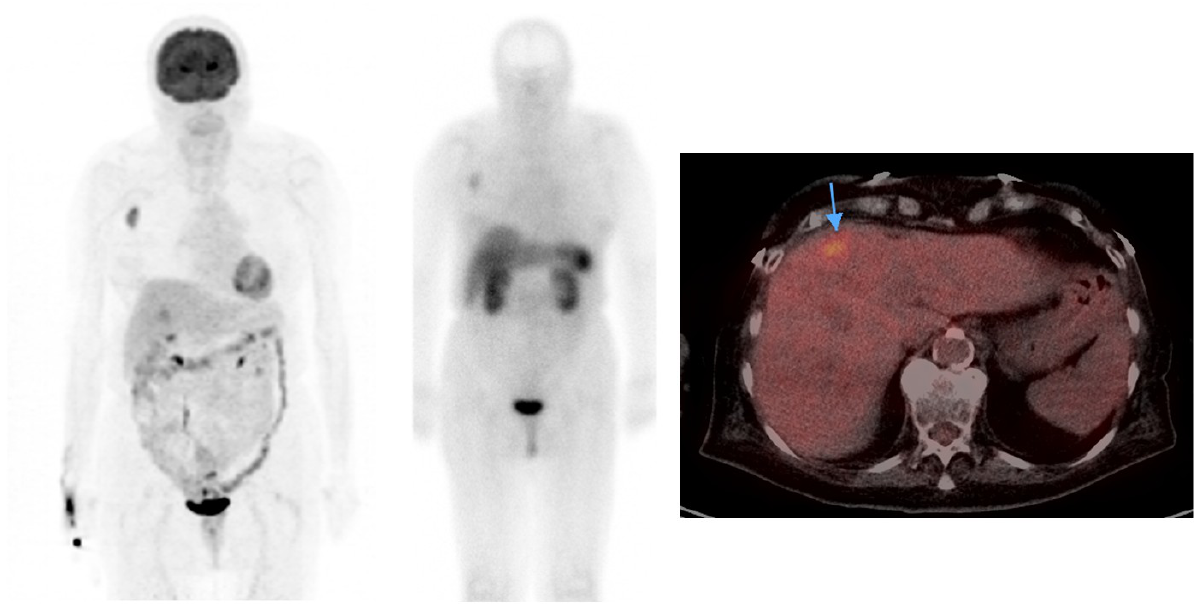
Figure 4. Subtle liver metastasis in a Merkel cell carcinoma patient that is not appreciable on octreotide scan. Right axillary nodal metastasis, on the other hand is visible on both studies.